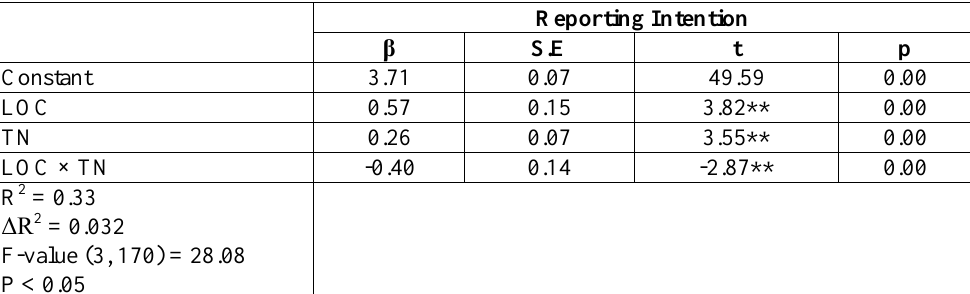
Table 4. Results of the Moderating Effect of Team Norm on the Relationship between Locus of Control and Reporting